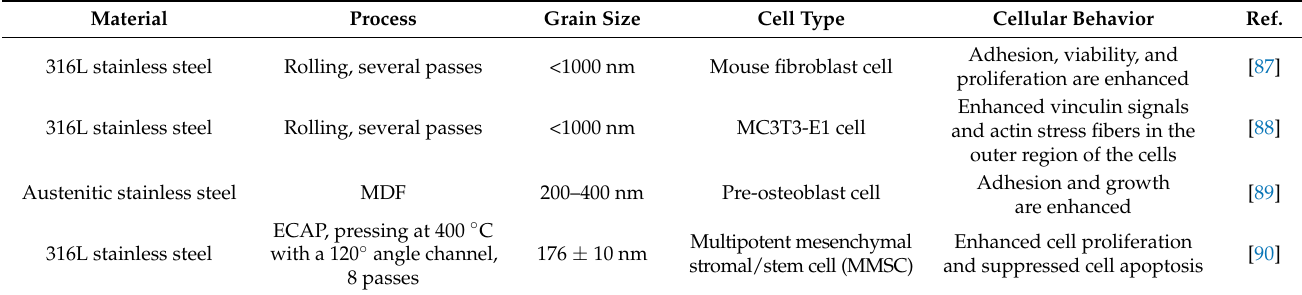
Table 4. Cell response to stainless steel after bulk grain